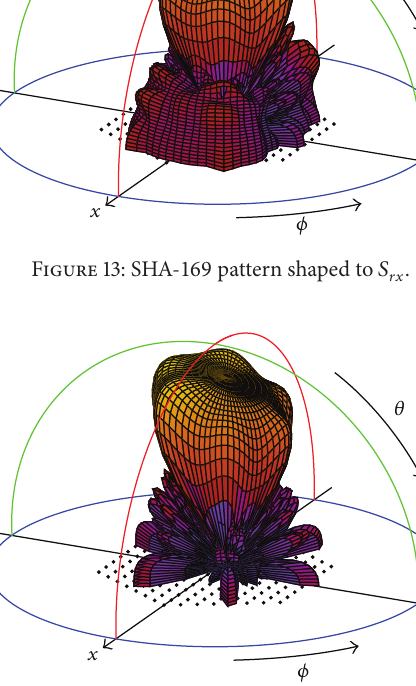
Figure 14: SHA- 169 pattern shaped to 𝑆 𝑟𝑦